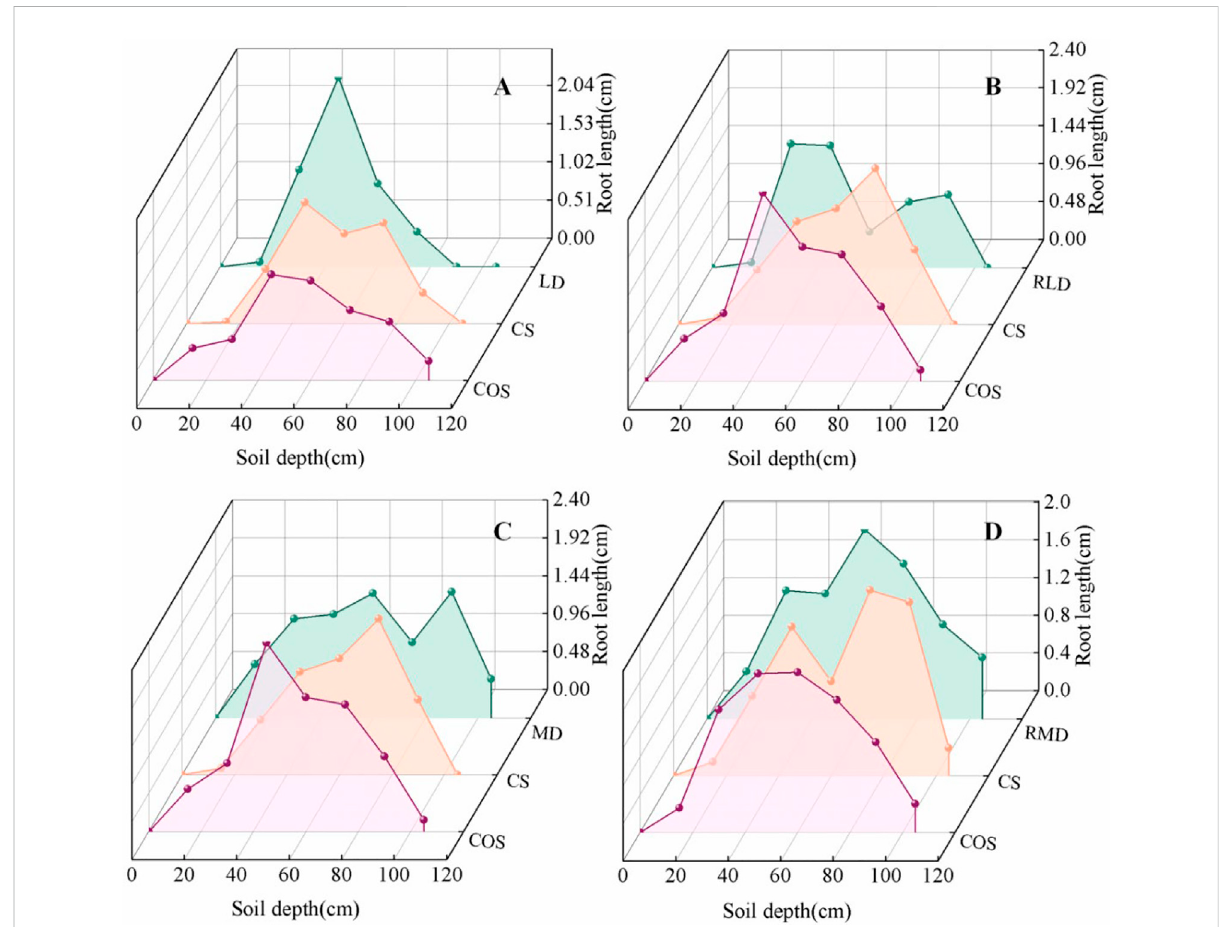
FIGURE 6 Verticaldistributioncharacteristicsofrootlengthofsummermaizeunderdifferentdroughtandpostdroughtrehydration. (A – D) arethevertical distribution characteristics of root length of LD, RLD, MD, and RMD,